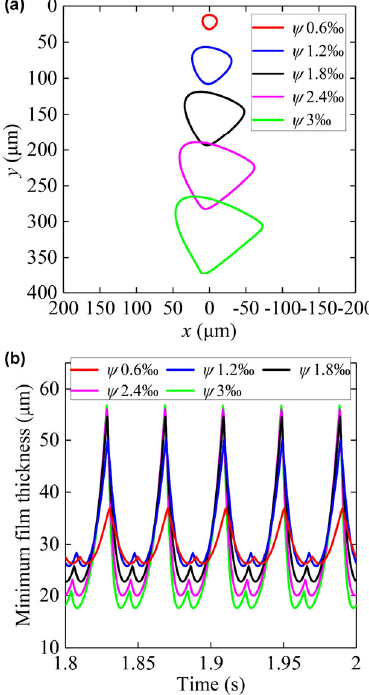
Fig. 12 (a) Journal center orbits and (b) dynamic minimum film thicknesses of a TPJB with static loads for different clearance